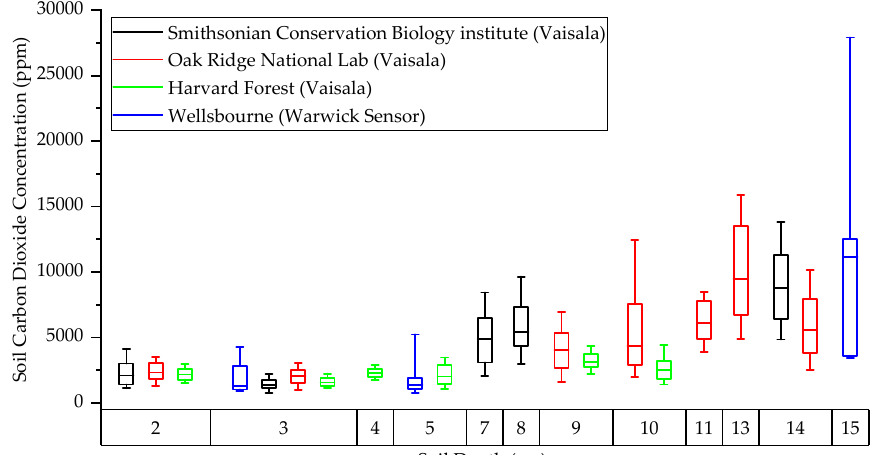
Figure 21. Box plot data comparisons between research institutes at similar times of year.